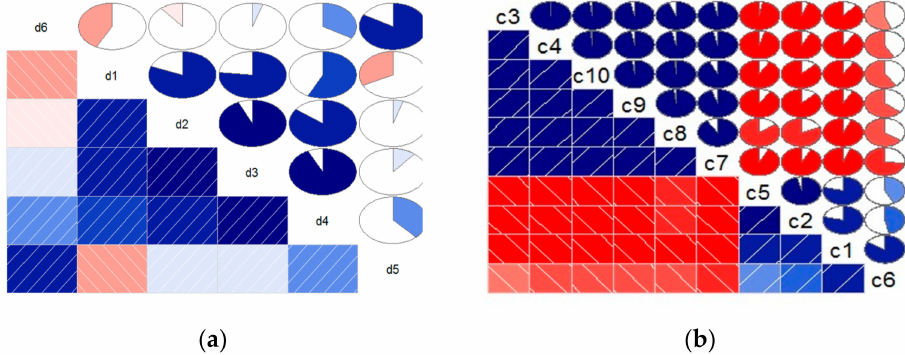
Figure 1. The diagram of causality between risk factors and risks. ( a ) The correlation between risk factors and water resource security; ( b ) the correlation between risk factors of energy